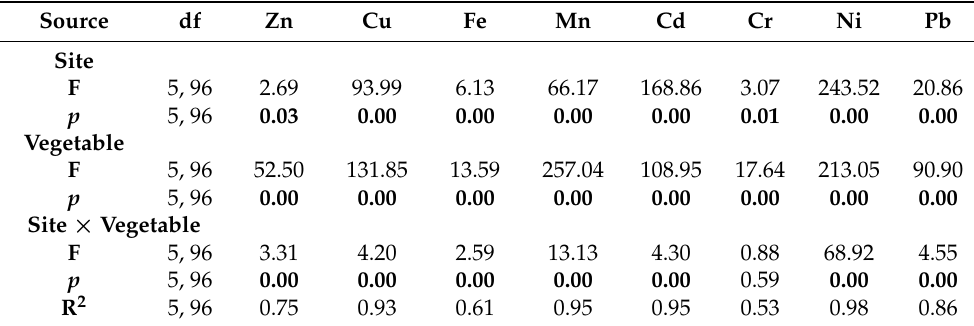
Table 3. Results of a two-way MANOVA of the soil–vegetable heavy metal transfer factor for six study sites in Multan,